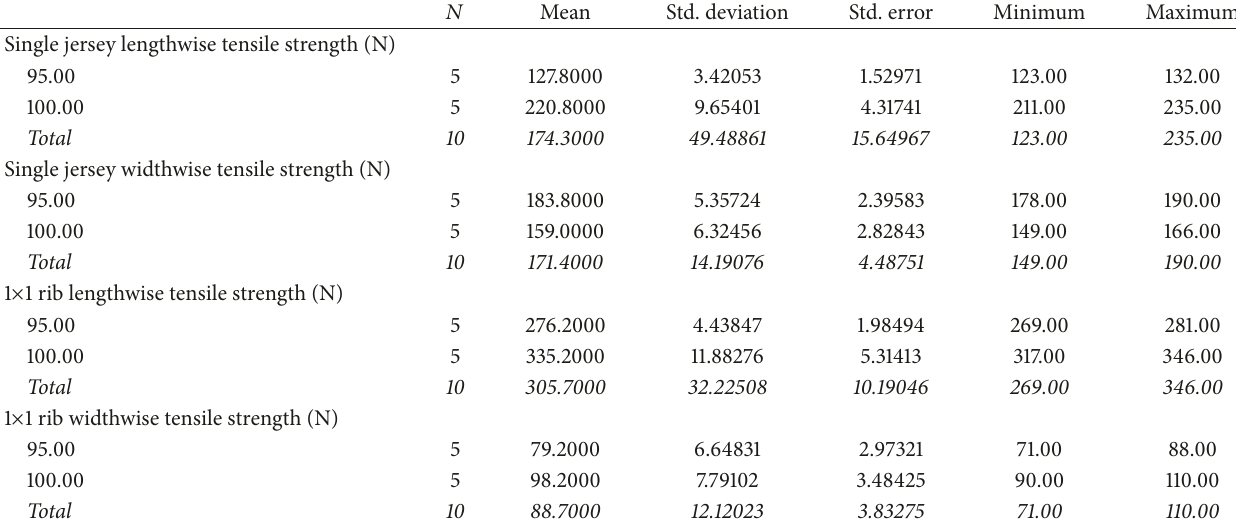
Table 7: Description for tensile strength of single jersey and 1 × 1 rib knitted fabrics made from 100% cotton and cotton/Lycra